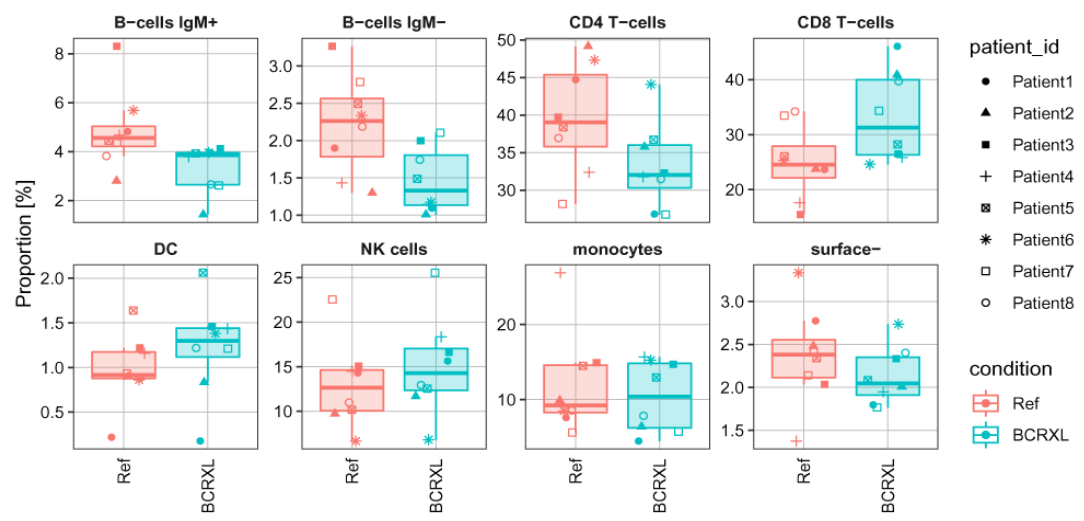
Figure 21. Relative abundance of the 8 PBMC populations in each sample, in the PBMC dataset, represented with boxplots. Values for the two conditions are indicated with different colors: red for the unstimulated (Ref) and blue for the stimulated with BCR/FcR-XL (BCRXL) samples. Values for each patient are indicated with different shape. The 8 cell populations are a result of manual merging of the 20 FlowSOM